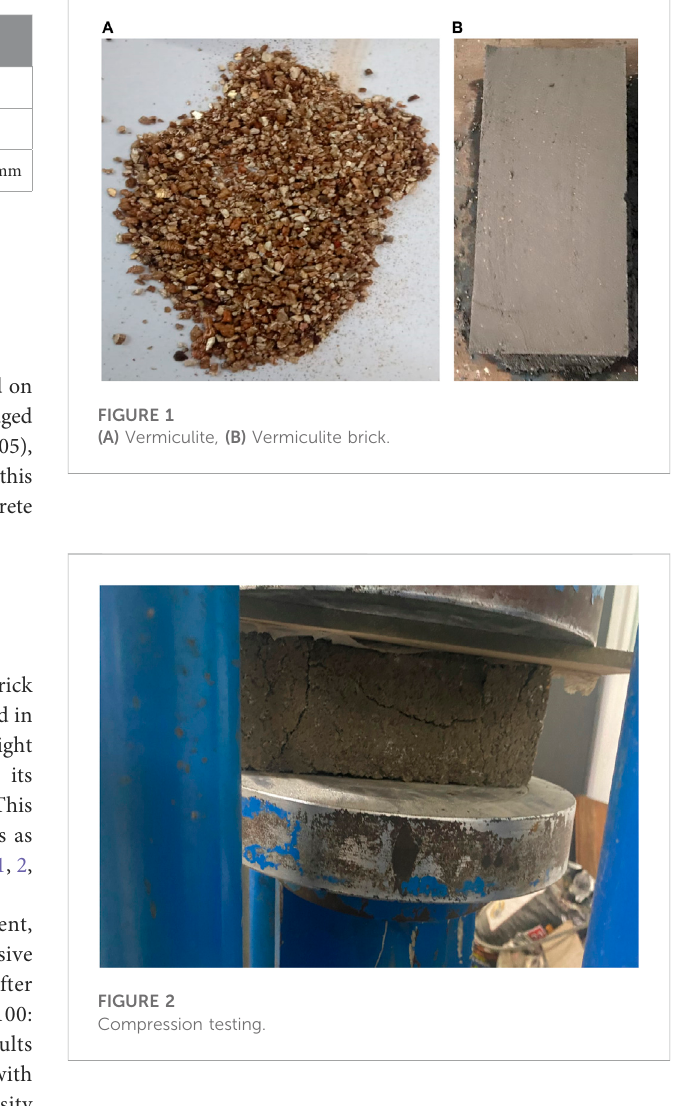
FIGURE 2 Compression